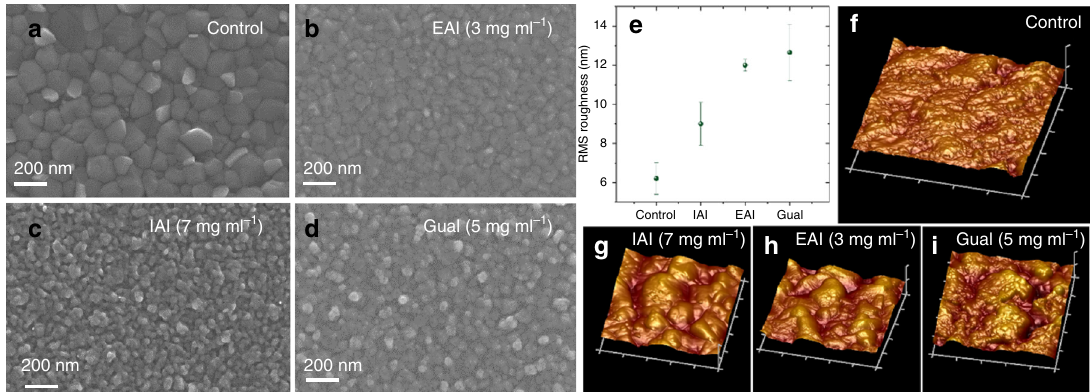
Fig. 3 Morphological characterization of perovskite layers: a – d SEM top view images of the perovskite fi lms with optimized treatment conditions. e AFM measurements ( x – y : 1 × 1 μ m, z: 0 ± 90 nm) reveal increasing RMS surface roughness for surface-treated perovskite absorbers: f control, g IAI, h EAI, and